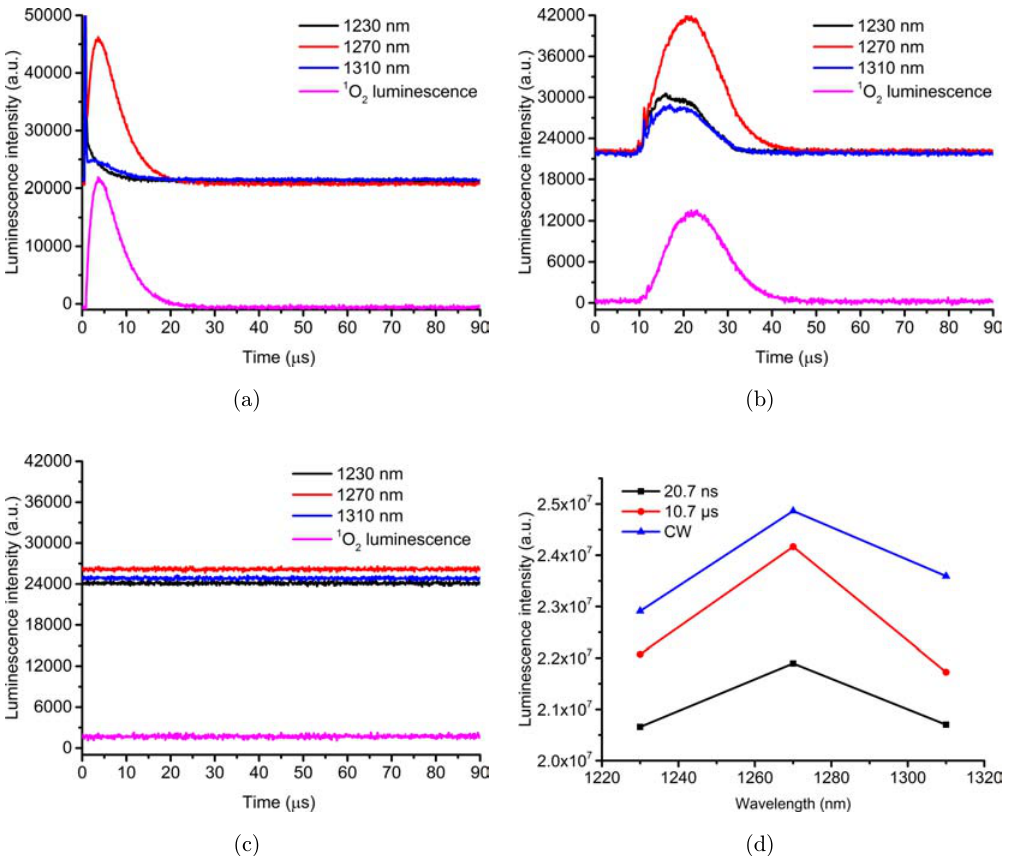
Fig. 2. Typical time-resolved luminescence spectra of three individual wavelengths (1230, 1270, 1310 nm) and the corresponding (cid:1) M RB in PBS with pulse widths of (a) 20.7 ns at 523 nm and (b) 10.7 (cid:1) s at 532 nm, 1 O 2 luminescence from photo-irradiation of 1.00 (c) CW at 532 nm; (d) the time-integrated luminescence spectra of (a), (b) and (c).